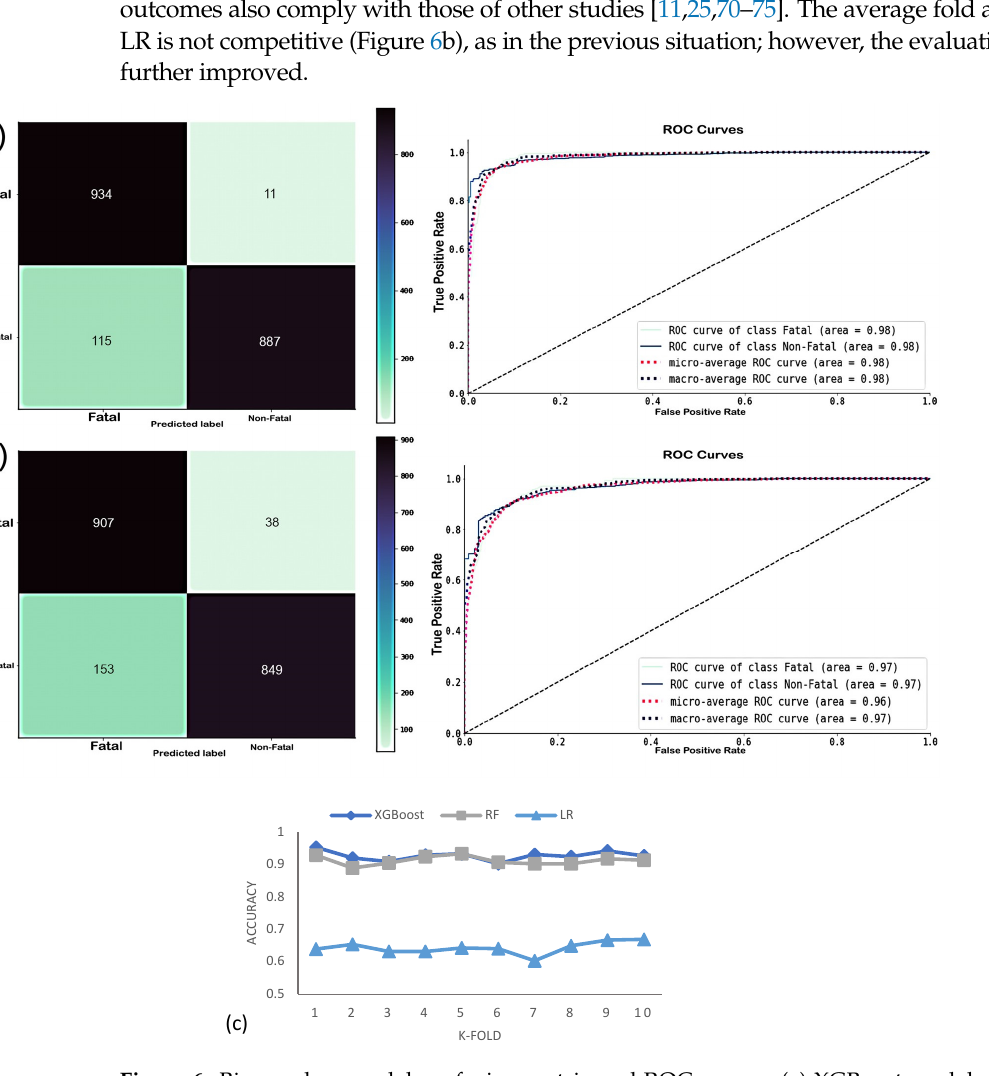
Figure 6. Binary-class model confusion matrix and ROC curves: ( a ) XGBoost model; ( b ) random forest model; ( c ) classifier accuracies by 10-fold binary-class.